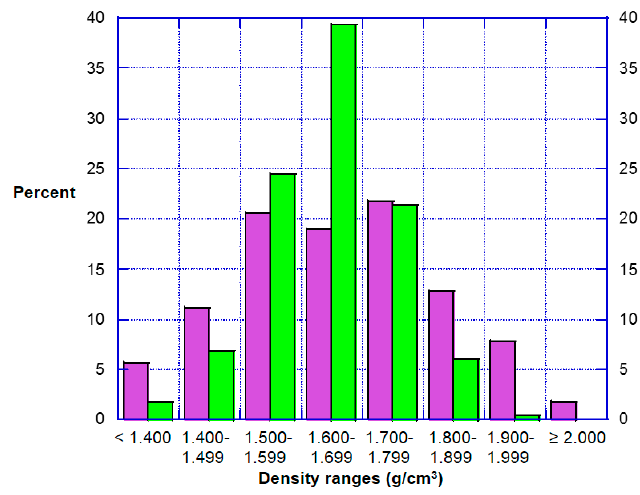
Figure 7. Crystal density distributions of C,H,N,O molecular compounds ( purple ) and nitrogen-rich C,H,N,O ionic compounds ( green ). Vertical axes are percentages.